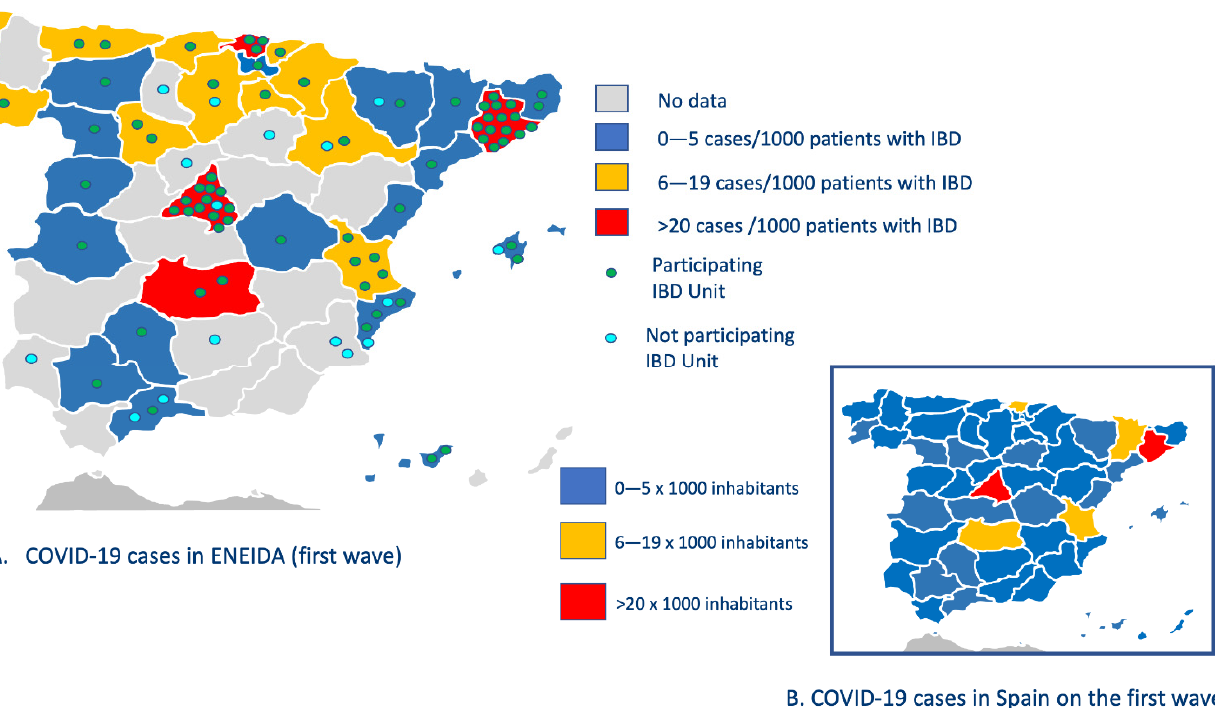
Figure 1. Geographic distribution of COVID-19 cases in the ENEIDA registry and comparison with the general Spanish population in the first wave of the pandemic.